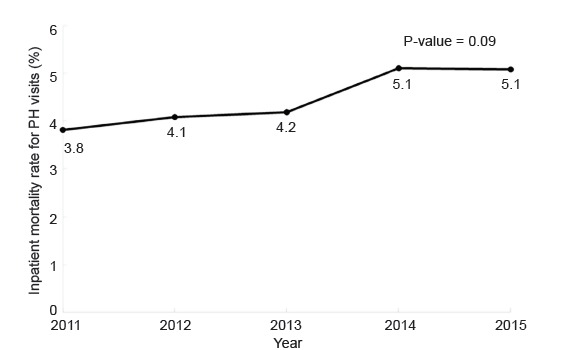
Change in inpatient mortality rate for pulmonary hypertension (PH) emergency department visits in the United States, 2011–2015.P = 0.09 for trend.